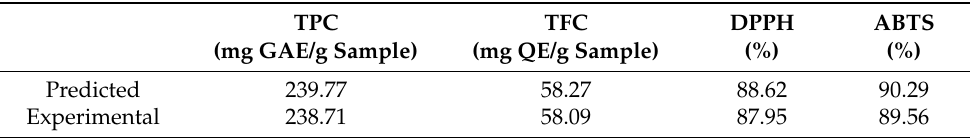
Table 3. Predicted and experimental values of responses.